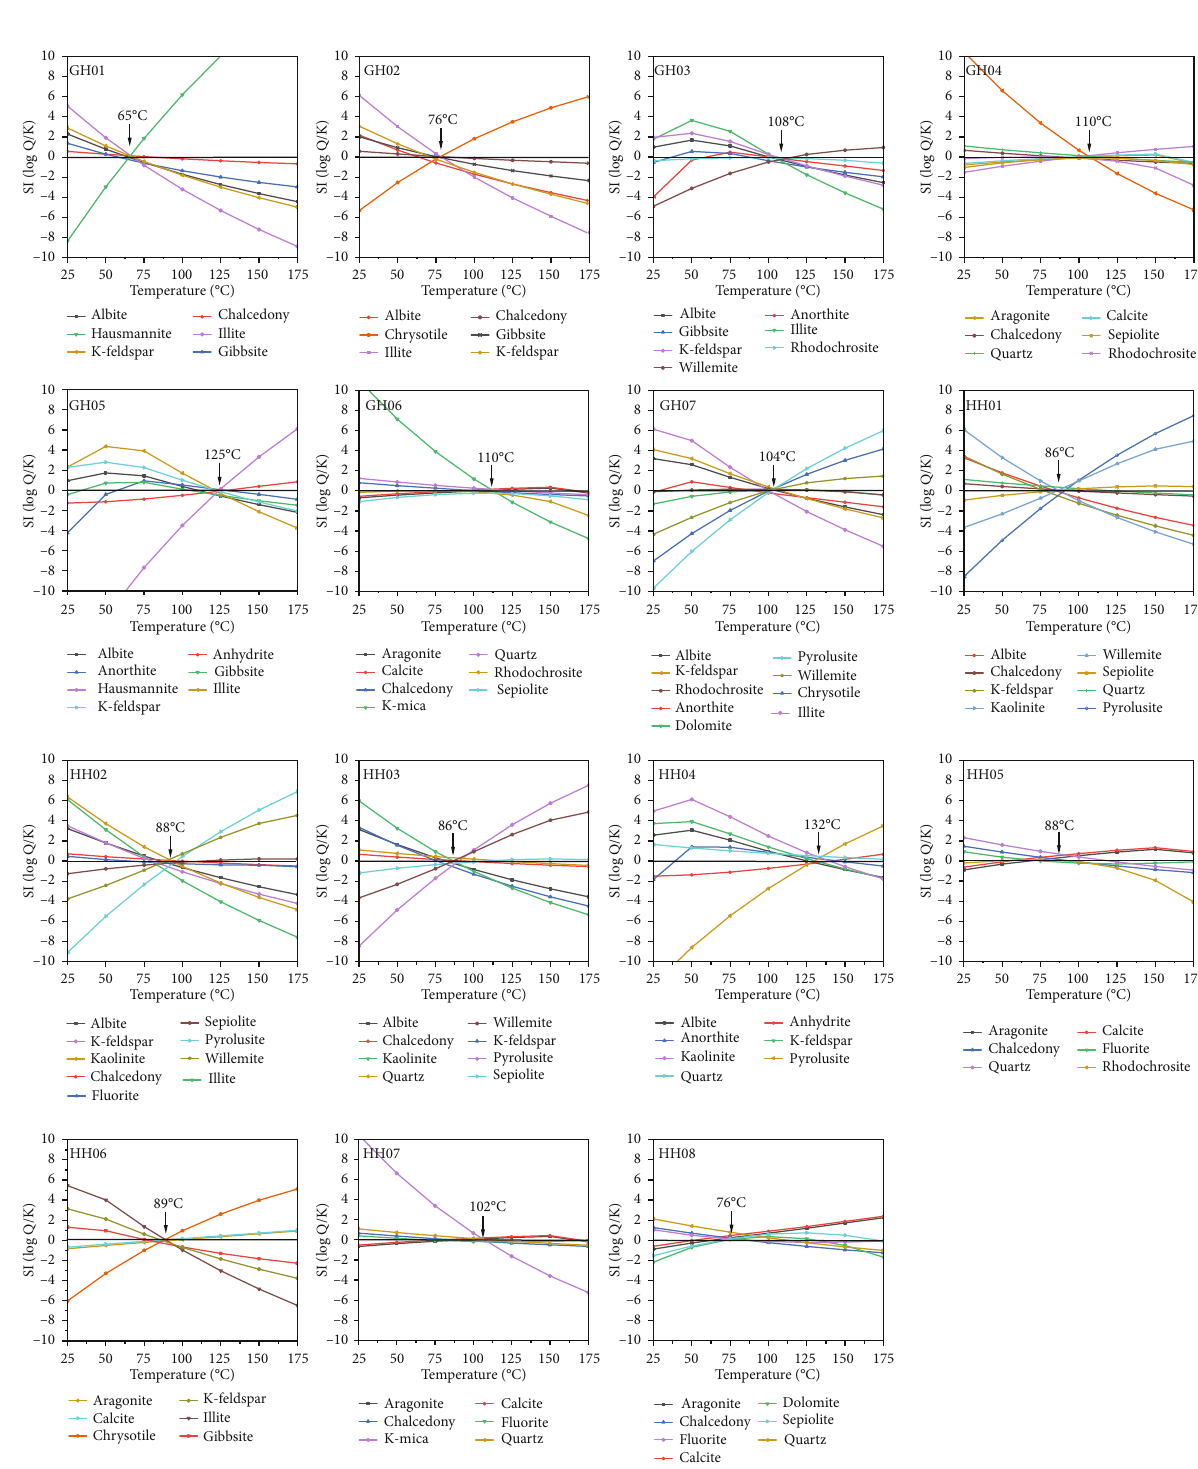
Figure 10: Fixed-Al mineral equilibrium diagrams showing the hot spring water samples in study